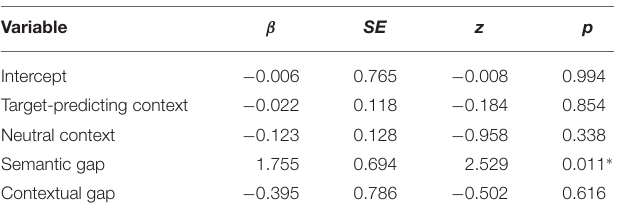
TABLE 3 | Regression coefficients of the binomial linear mixed effects model for Experiment 1.